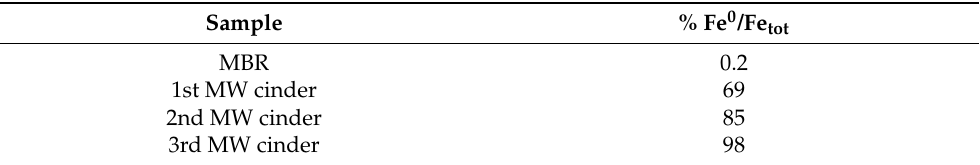
Figure 11. Comparison of the XRD spectra of modified BR (MBR), cinder after 1st microwave roasting reduction, cinder after 2nd microwave roasting reduction and cinder after 3rd microwave roasting reduction. Table 7. Percentage of metallic iron/total iron content of modified BR and the three microwave cinders determined with Zhiyong Xu